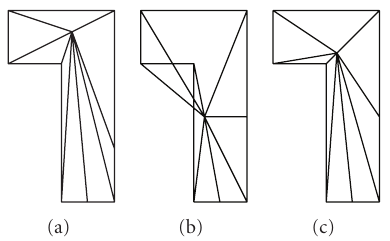
Figure 14: Torsion spring e ff ect: (a) initial grid, (b) cell inversion, and (c) torsion